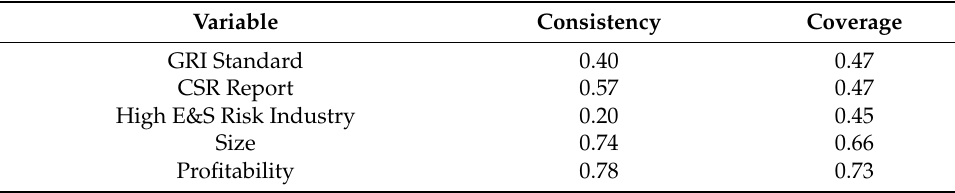
Table 5. Analysis of QCA necessary